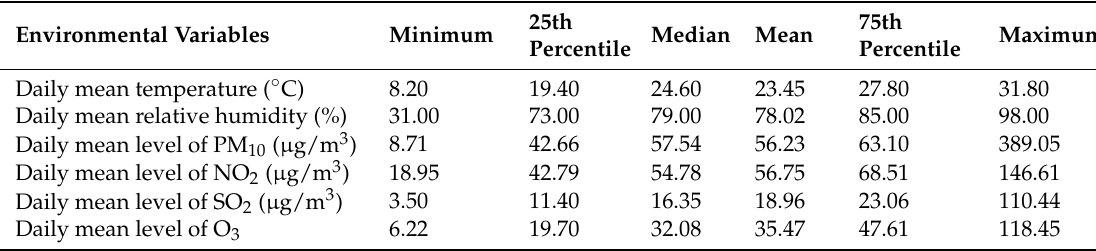
Table 3. Descriptive statistics for environmental variables in Hong Kong,